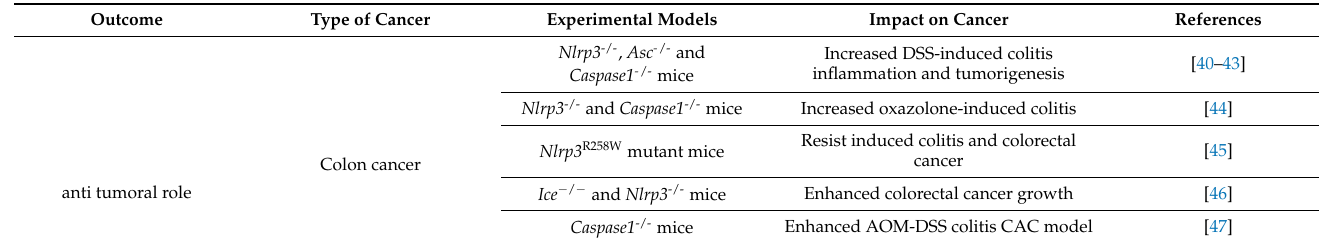
Table 1. Role of NLRP3 inflammasome in